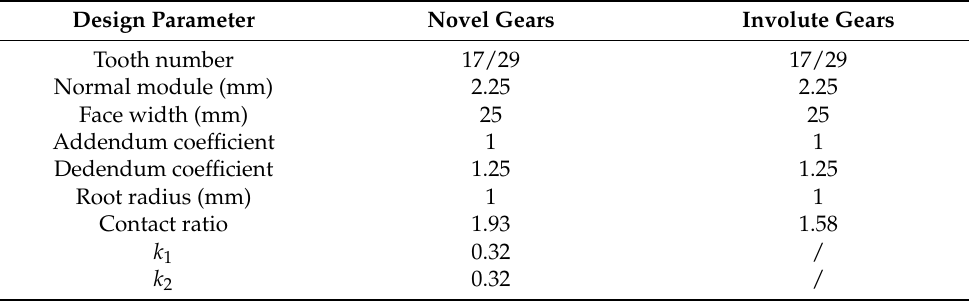
Table 1. Design parameters of gears.